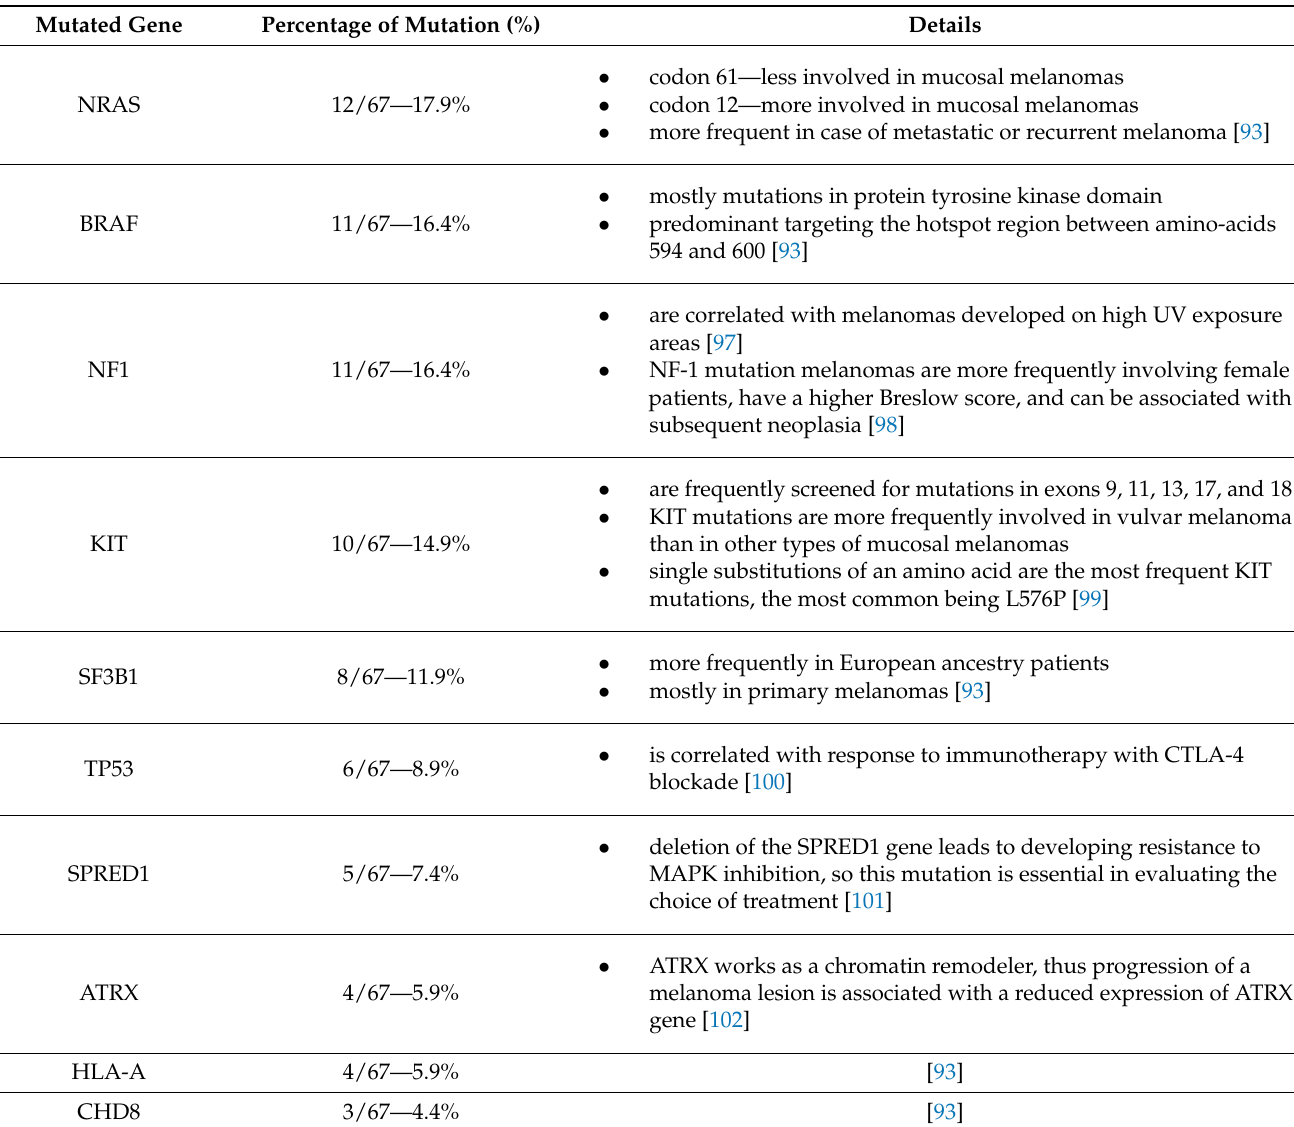
Table 2. The main mutations that occur in melanomas and their frequency of occurrence [93,97–102]. Mutated